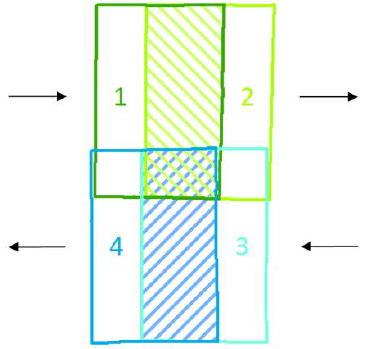
Figure 1. Forward and side overlaps of DAP